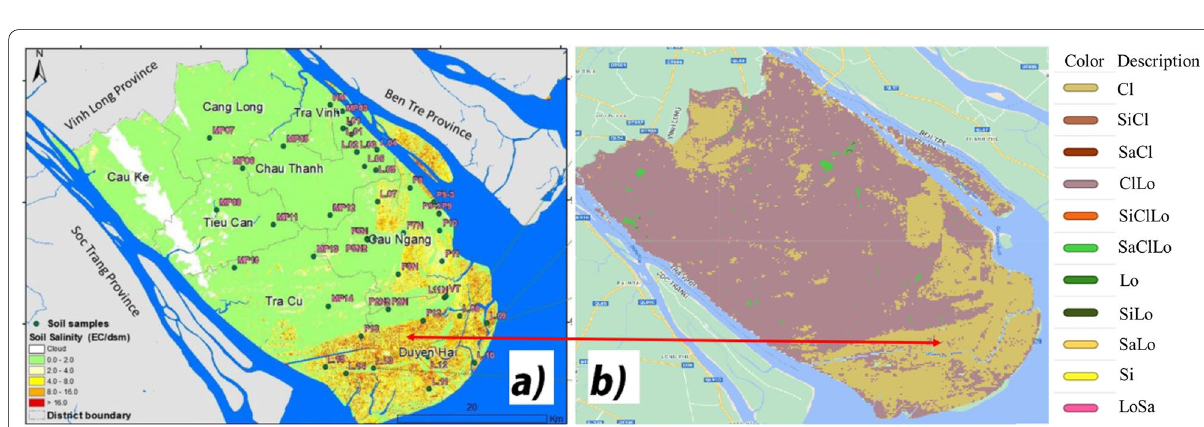
Fig. 2 Comparison of soil salinity map ( a ) created by the Nguyen et al. (2020) and soil texture map derived from the USDA system ( b